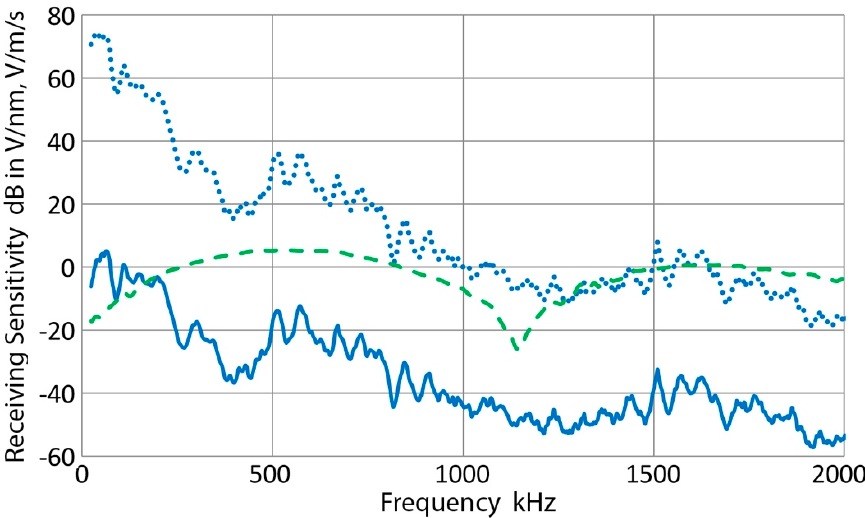
Figure 22. Receiving sensitivity of Olympus V101. The displacement receiving sensitivity to bar waves is shown in solid blue curve. Green curve is the displacement receiving sensitivity to normally incident waves from reference [4]. The velocity sensitivity corresponding to the solid blue curve is given in dotted blue curve.